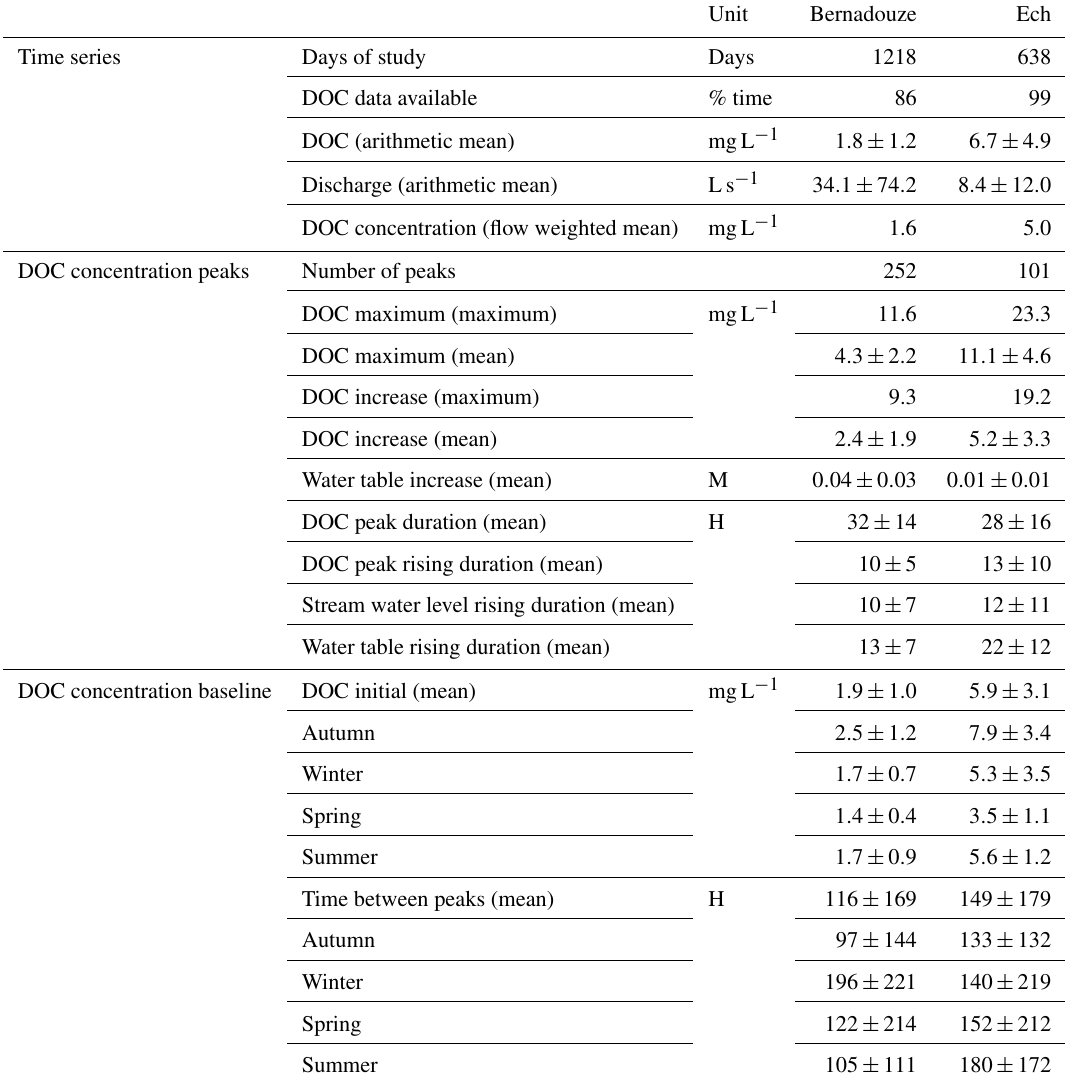
Table 2. Time series and DOC concentration peak metrics in Bernadouze over the 1 September 2015 to 31 December 2018 period and in Ech over the 22 May 2015 to 13 February 2019 period. Mean notations correspond to arithmetic means which are given with standard